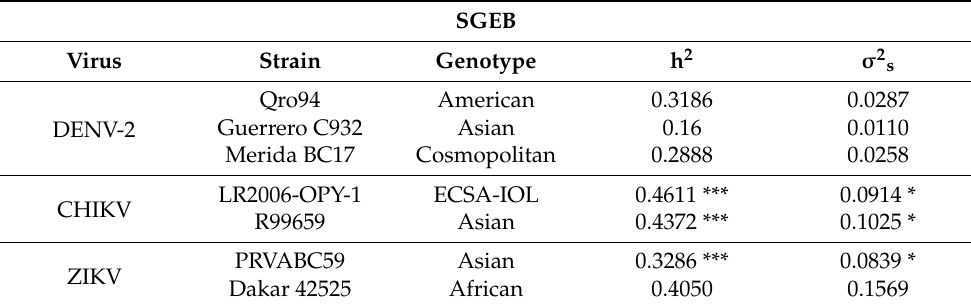
Table 3. Quantitative genetic analysis of SGEB in Aedes aegypti . Each analysis corresponds to one of the seven virus strains tested for log 10 (PFU)/saliva. We used PROC MIXED in SAS to obtain restricted maximum likelihood (REML) to estimate quantitative genetic parameters. The greater the variance in sire means, the larger the heritability. SGEB Virus Strain Genotype h 2 σ 2 s Qro94 American 0.3186 0.0287 Guerrero C932 Asian 0.16 0.0110 DENV-2 Merida BC17 Cosmopolitan 0.2888 0.0258 LR2006-OPY-1 ECSA-IOL 0.4611 *** 0.0914 * CHIKV R99659 Asian 0.4372 *** 0.1025 * PRVABC59 Asian 0.3286 *** 0.0839 * ZIKV Dakar 42525 African 0.4050 0.1569 σ 2 s = average variance among offspring of a single sire; h 2 = narrow-sense heritability (h 2 = Va/Vp). * p =